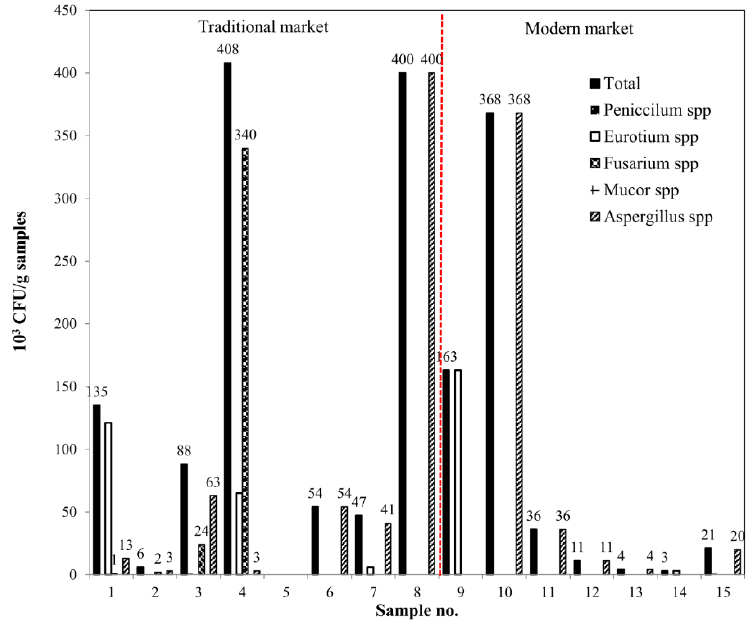
Figure 1. Microbiota of dried and powdered chili from the traditional and the modern market.